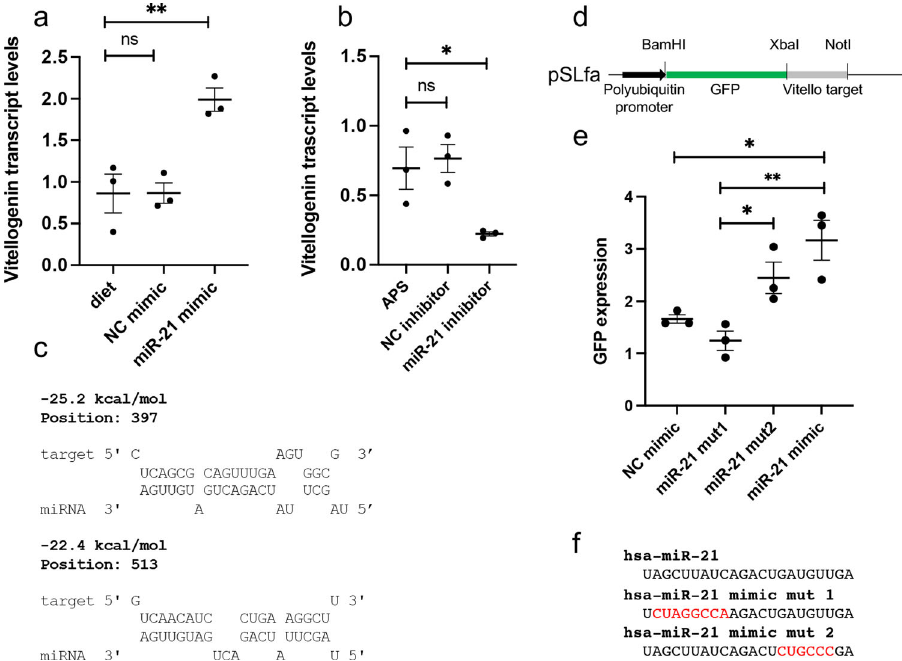
Fig. 6 Vitellogenin is a direct target and is upregulated by hsa-miR-21-5p. a Mosquitoes were fed with arti fi cial diet only or on diet containing NC mimic or hsa-miR-21-5p mimic. They were collected 12 h after feeding, and vitellogenin levels relative to RPS17 were determined using RT-qPCR. Each data point represents a single mosquito. One-way ANOVA with Tukey ’ s post-hoc multiple comparisons were used for data analysis. ns, not signi fi cant; ** p < 0.01. b Mosquitoes were injected with APS buffer, a negative control (NC) inhibitor or hsa-miR-21-5p inhibitor. Four days after injection mosquitoes were fed on a human volunteer and 12 h after feeding levels of vitellogenin relative to RPS17 were detected using RT-qPCR. One-way ANOVA with Tukey ’ s post-hoc multiple comparisons were used for data analysis. ns, not signi fi cant; * p < 0.05. c Bioinformatic analysis using RNAHybrid (v2.2.1) showing two different target sites in the vitellogenin gene. d The vitellogenin target sequences were cloned downstream of GFP in the pSLfa vector. e Aag2 cells were co- transfected with the plasmid and NC mimic, hsa-miR-21-5p mimic, or two different mutant mimics. GFP transcript levels relative to RPS17 were determined by RT-qPCR 48 h after transfection. One-way ANOVA with Tukey ’ s post-hoc multiple comparisons were used for data analysis. * p < 0.05; ** p < 0.01. f The sequences of hsa-miR-21-5p and mutated residues (red residues) are shown below the graph. Error bars in all the graphs represent standard error of the mean (SEM) in three biological